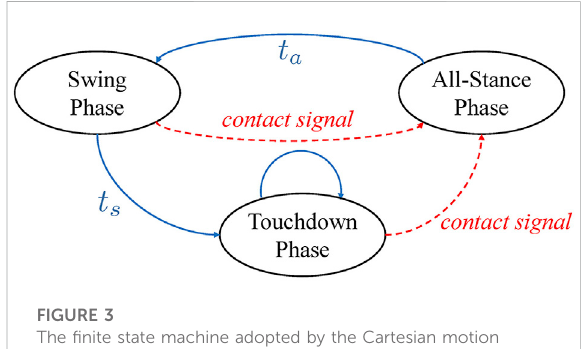
FIGURE 3 The fi nite state machine adopted by the Cartesian motion planner. The ellipses represent the three planning phases with the arrows indicating the possible transitions between them. t a and t s denote the periods of the All-Stance Phase and the Swing Phase, respectively. The dashed red arrows, however, indicate the time-independent transitions that can only be triggered by the actual contact